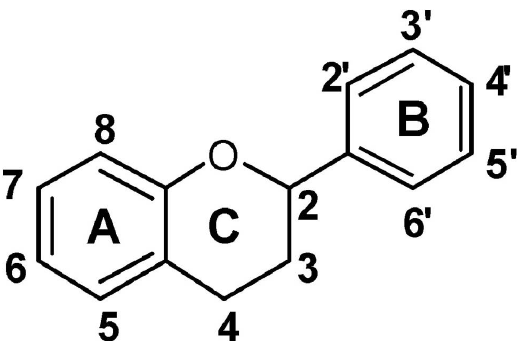
Figure 3. Basic structure of